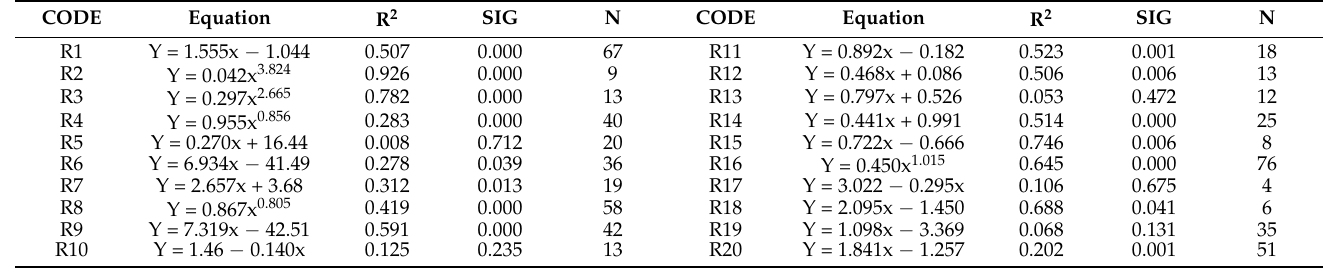
Table 3. TLS-measured soil loss as a function of WEPP-predicted soil loss along